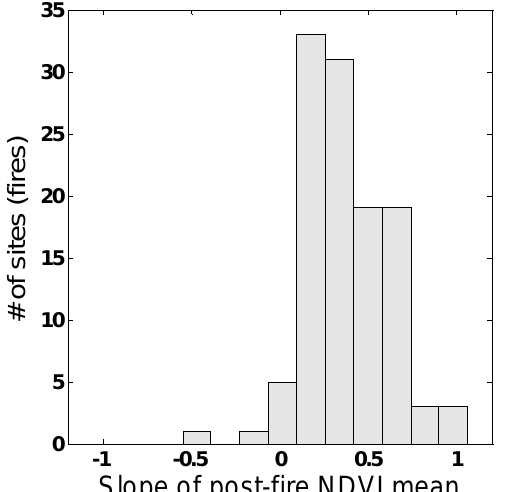
Figure 3. Boxplots illustrating the differences in post-fire NDVI slope across ecoregions at the Domain (a) , Division (b) , and Province (c) levels. The ecoregions indicated here